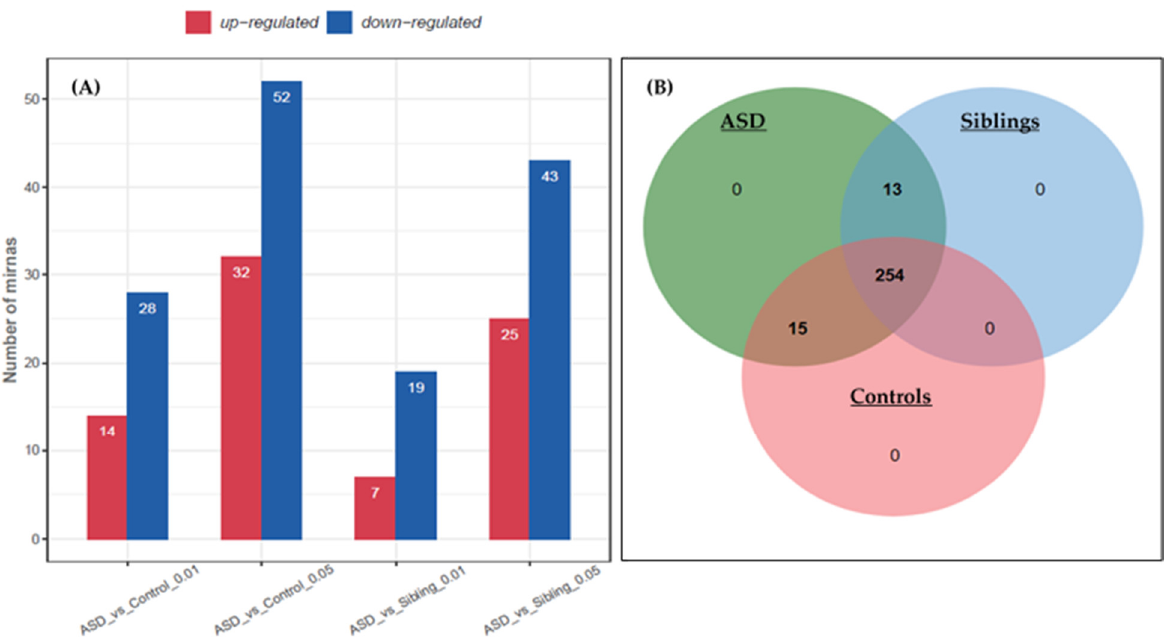
Figure 2. Differential expression of miRNAs in ASD and control LCLs as well as in ASD and siblings. ( A ) Total number of miRNA expression at p < 0.01 and p < 0.05. ( B ) Venn diagram of all the dysregulated miRNAs in the groups, showing miRNAs which are unique and common in the three groups. Table 2. Top differentially expressed miRNAs in the ASD vs. control groups and ASD vs. siblings.